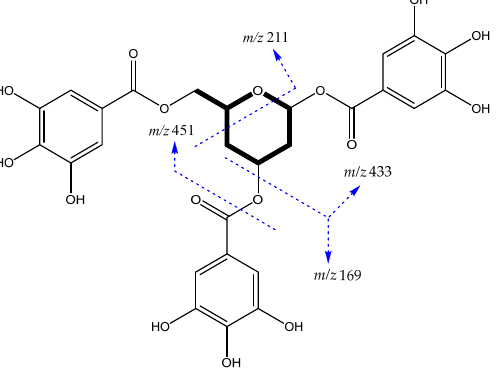
Figure 1. Trigalloyl-dideoxyglucose structure and main fragments.